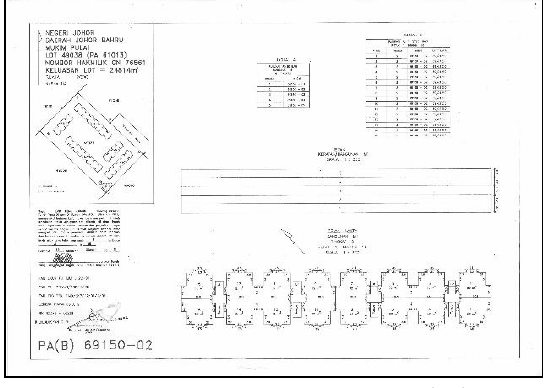
Figure 1. Example of Certified Plan